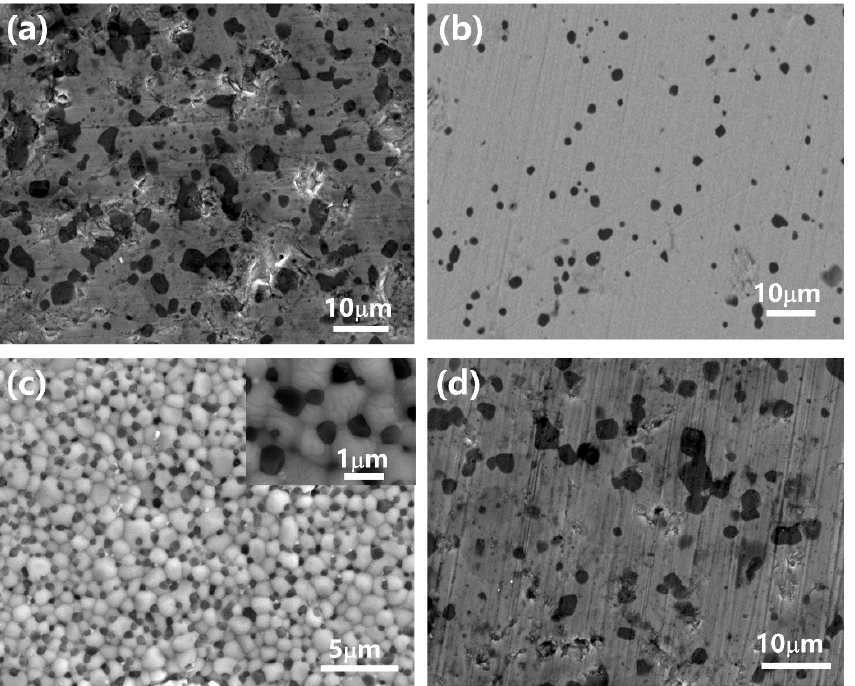
Figure 8. SEM micrographs of the MgO-Y 2 O 3 sintered by HP method using the hydrothermal powders of ( a ) 230C-0S, ( b ) 160C-5S, ( c ) 190C-5S and ( d ) 220C-5S, respectively.